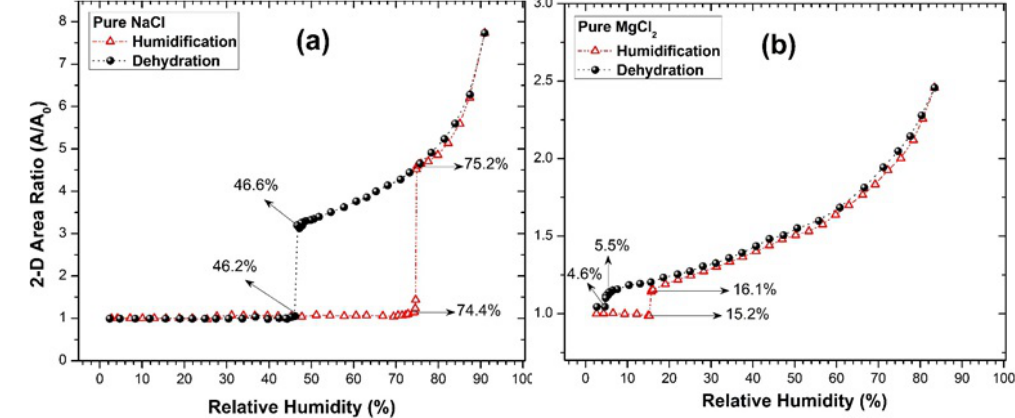
Figure 1. Plot of 2-D area ratio ( A / A 0 ) of nebulized pure (a) NaCl and (b) MgCl 2 as a function of the RH. The recorded transition RHs in both humidification and dehydration processes are marked with